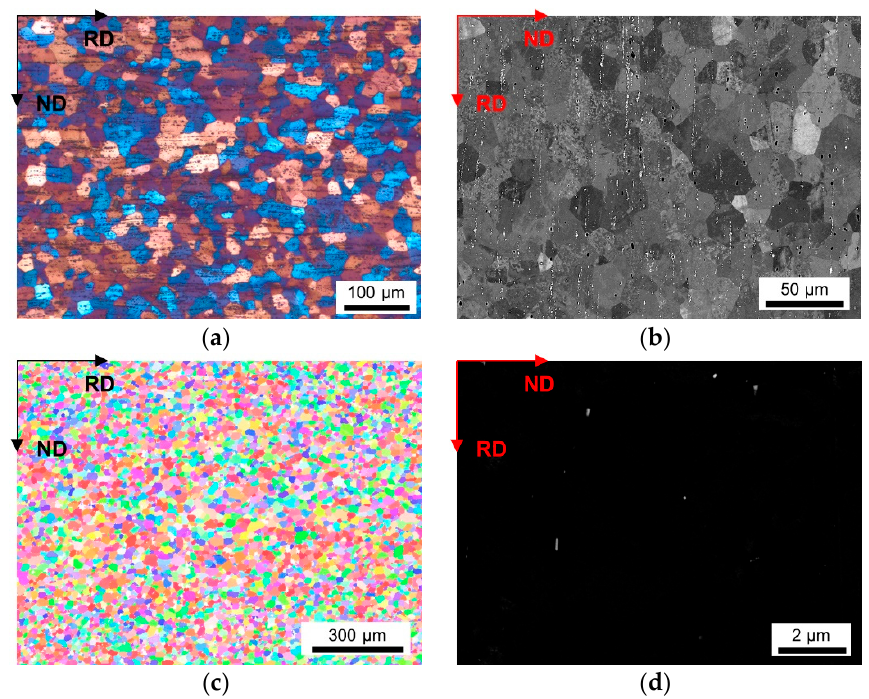
Figure A18. Microstructure of the soft annealed HFe-LMn cast under NR-C conditions, homogenized at 500 °C and cold rolled to a CRD of 35%. ( a ) LOM. ( b ) BSE image. ( c ) EBSD IPF map in RD–ND plane. ( d ) BSE micrograph showing dispersoids.